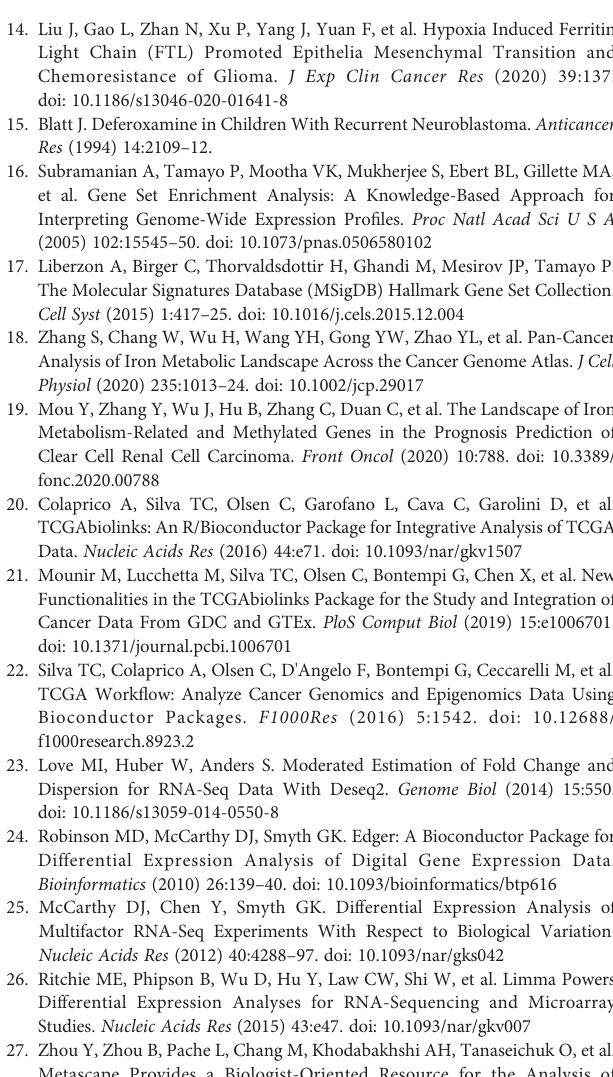
Supplementary Figure 1 | (A – O) , Kaplan – Meier survival analysis of the risk signature in LGG patients strati fi ed by the age, gender, WHO grade, pathological subtypes, IDH1 mutation status, MGMT promoter methylation status, and 1p19q codeletion status. Supplementary Figure 2 | Distribution of risk scores between LGG and GBM. **** P <